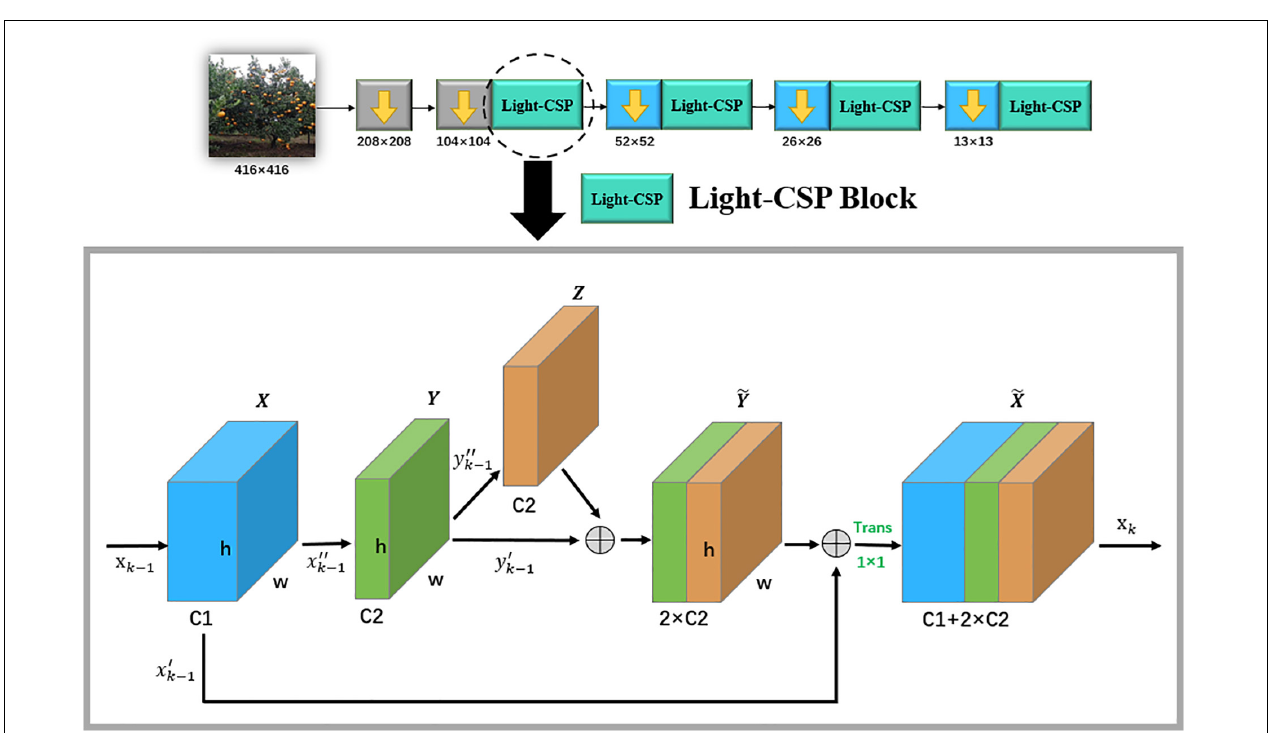
FIGURE 4 | Internal flow diagram of each Light-CSP block in the backbone